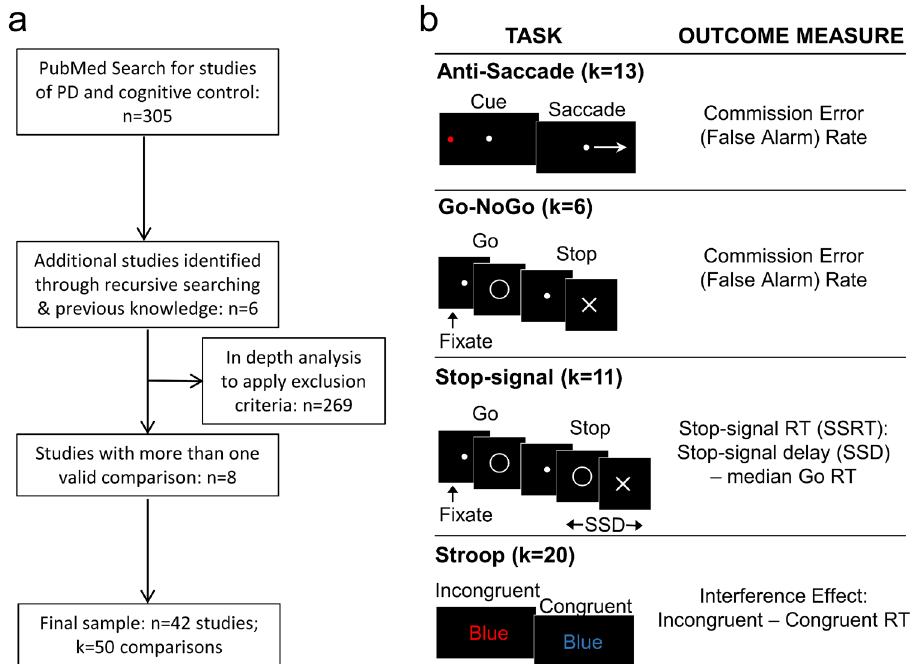
Fig. 1 a Flow chart of meta-analysis procedure. b Left : simpli fi ed schematic for each task used in the meta-analysis. Right : outcome measure used for each task; we chose the measure that was most commonly reported across studies for each